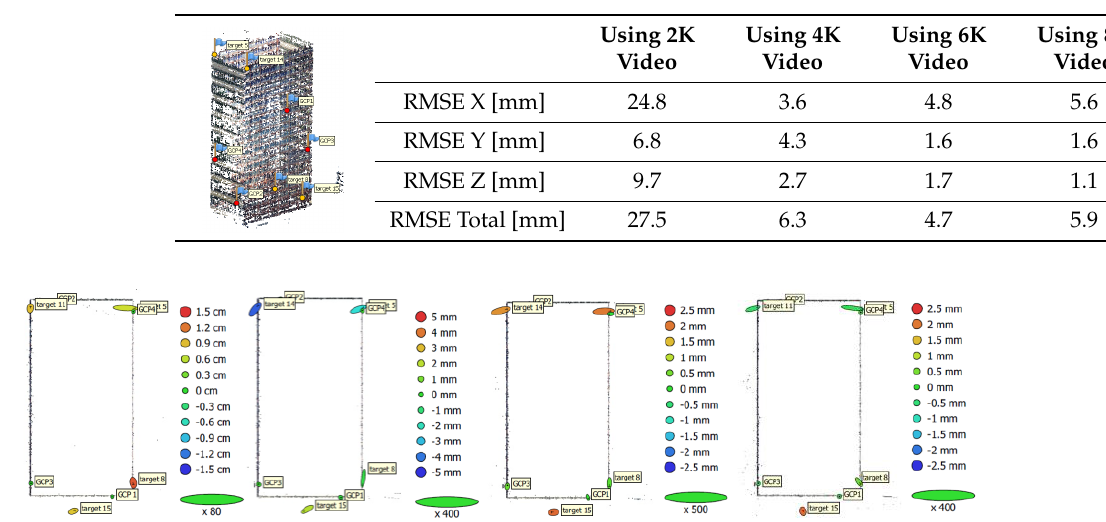
Figure 15. Checking the internal accuracy of the second test. ( a ) The selected planar façade (blue patch) for testing the relative accuracy. ( b ) Planar fitting error evaluation at the four video resolutions.